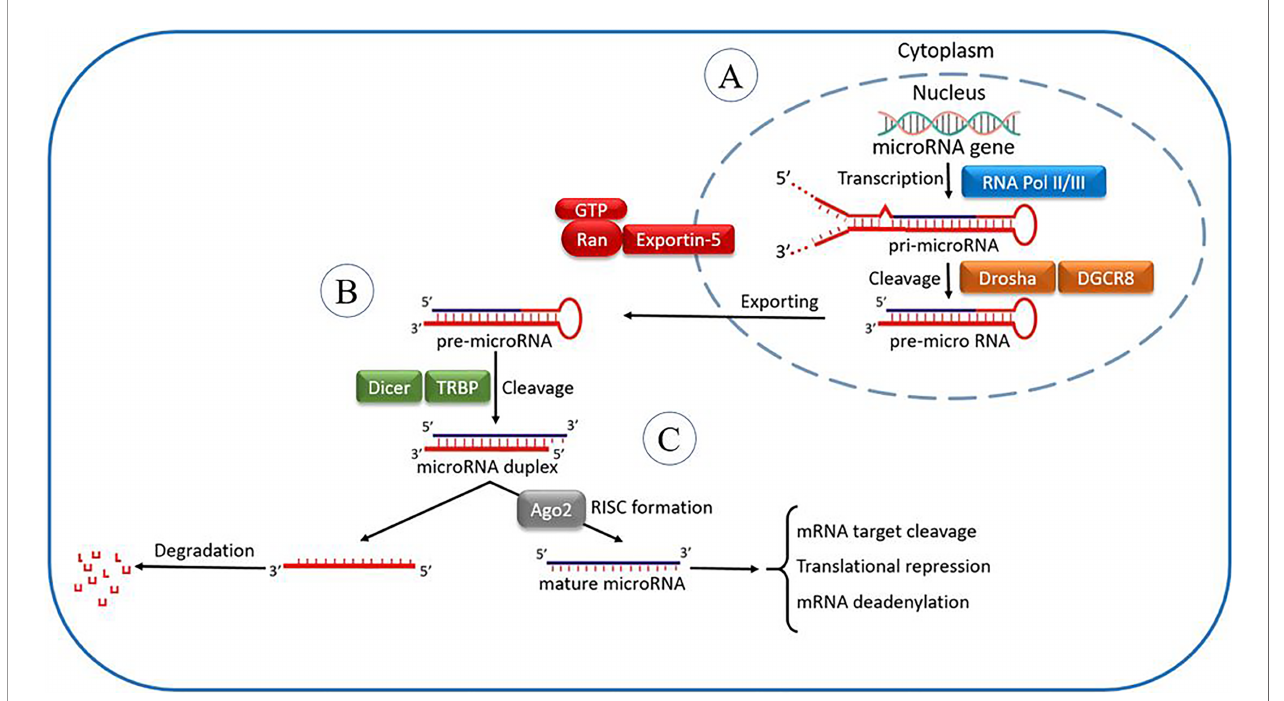
FIGURE 1 | The microRNA processing pathway. It is postulated that the miRNA processing pathway is linear and universal to all mammalian miRNAs. This process includes the production of the primary miRNA transcript (pri-miRNA) by RNA polymerase II or III and cleavage of the pri-miRNA by the microprocessor complex Drosha – DGCR8 (Pasha) in the nucleus (A) . The resulting precursor hairpin, the pre-miRNA, is exported from the nucleus by Exportin-5 – Ran-GTP. In the cytoplasm, the RNase Dicer in complex along with RNA-binding cofactor of Dicer complexes known as transactivation response element RNA-binding protein (TRBP) cleaves the pre-miRNA hairpin to its mature length (B) . The mature miRNA ’ s functional strand is loaded together with Argonaute (Ago2) proteins into the RNA-induced silencing complex (RISC), where it guides RISC to silence target mRNAs through mRNA cleavage, translational repression, or deadenylation, whereas the passenger strand is degraded (C)